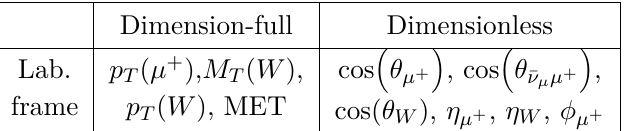
is the angle between i,j